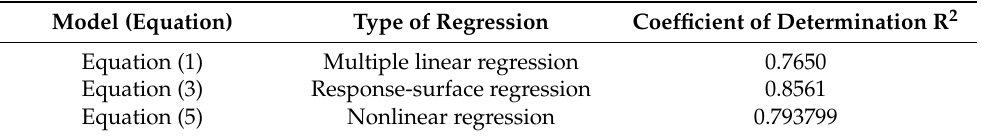
Table 6. Comparison of coefficient of determination with different regression models for Co–28Cr– 6Mo alloy.